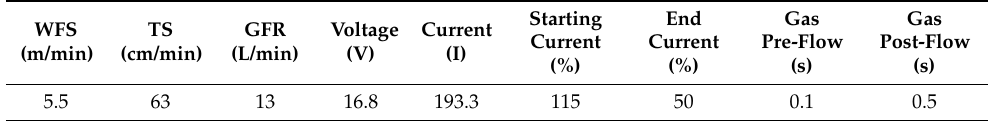
Table 8. The optimized process variables utilized for the bulk fabrication of SS410 thick walls using the CMT—based WAAM process.